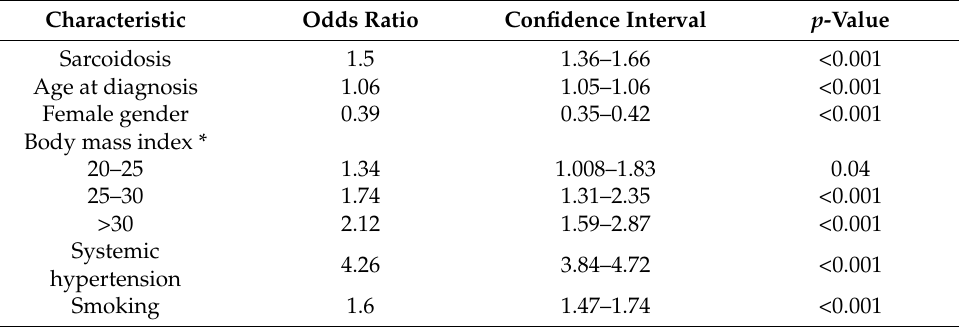
Table 2. Logistic regression for covariates associated with ischemic heart disease.